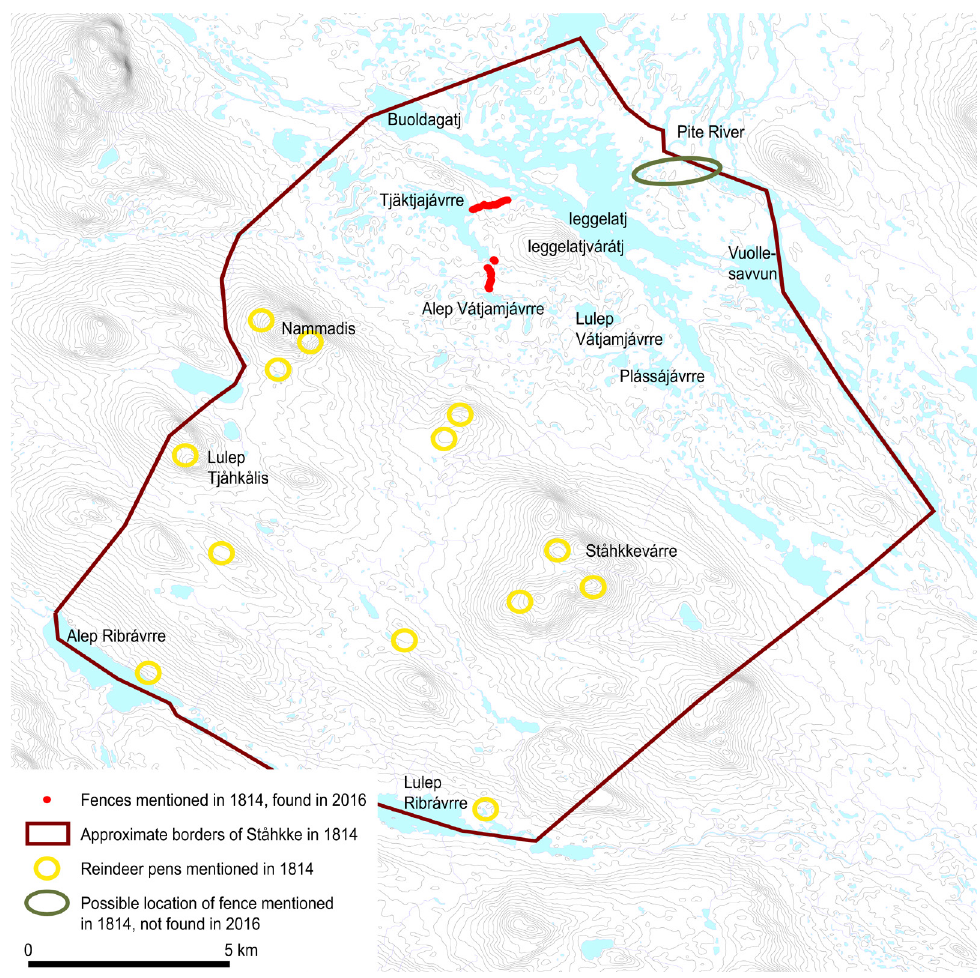
Figure 8. The fences that we found by Lake Ieggelatj were first mentioned in a protocol from 1814 concerning the definition of the borders of the Ståhkke taxation land in the Luokta Sami community (CR 1815b). One of the discovered fences went between Lakes Ieggelatj and Tjäktjajávrre (ca 1000 m, including a 60 m lake), the other be- tween Lakes Tjäktjajávrre and Alep Vátjamjávrre (ca 700 m). These two fences were separated by about 1500 m of water in Lake Tjäktjajávrre. A third fence was mentioned in the protocol as going from Ieggelatj to the Pite River, but we could not find that part. As defined in the protocol, the Ståhkke land extended over approximately 30 000 hectares. In the south, it included a couple of low alpine mountains with summits over 700 m a.s.l. On and around those mountains, there were 13 reindeer pens that have been tentatively marked on the map. Such a large number of pens is typical of intensive reindeer husbandry focused on milking (Ruong 1944: 94). The northern part of the Ståhkke land was characterized by a couple of large lakes and the Pite River, which also forms the northeastern border. The main fishing lakes mentioned in the protocol were Ieggelatj, Buoldagatj, and Vuollesavvun. By Lake Tjäktjajávrre we found the remains of a fishing hut and a boat. ©